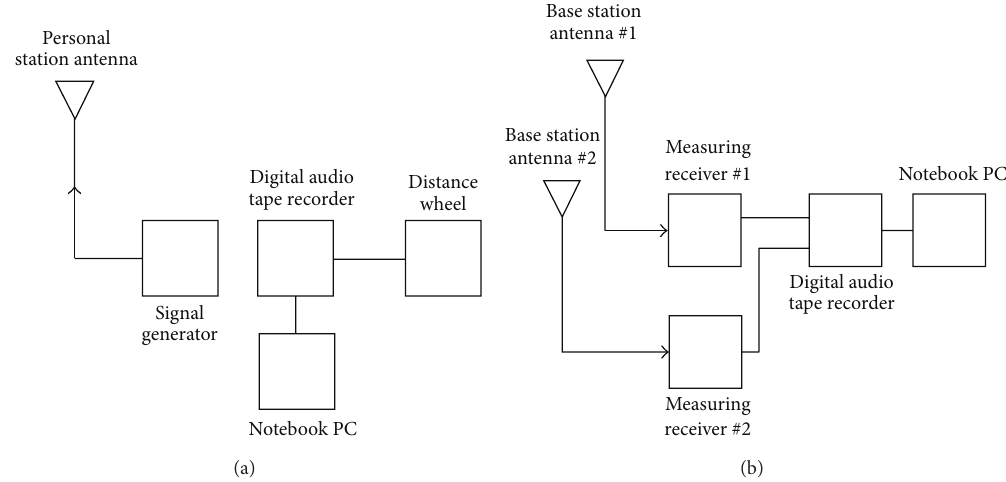
Figure 17: Block diagram of RZL measurement equipment. (a) Personal station. (b) Base station.